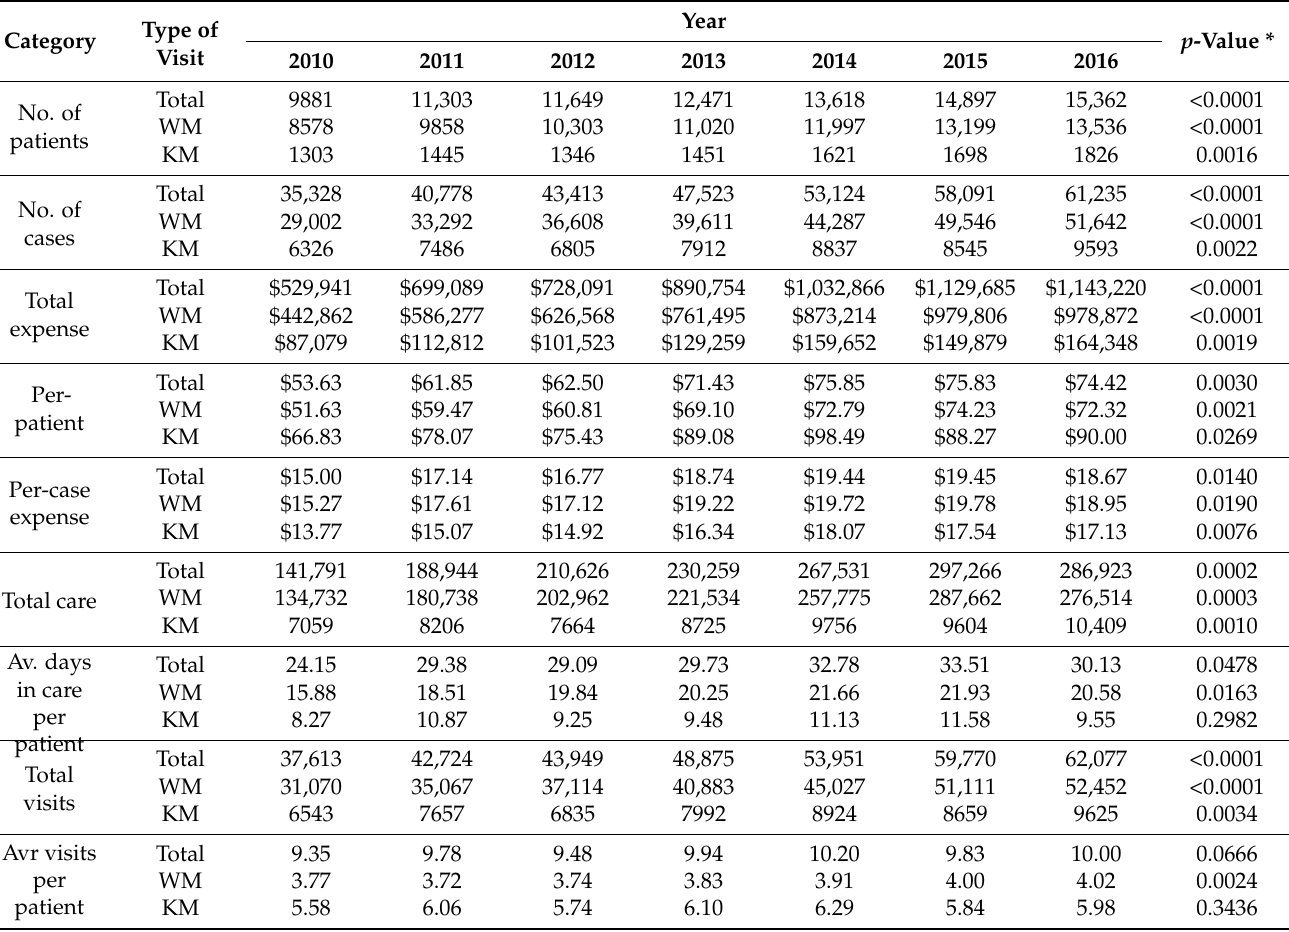
Table 1. General medical service use for patients with